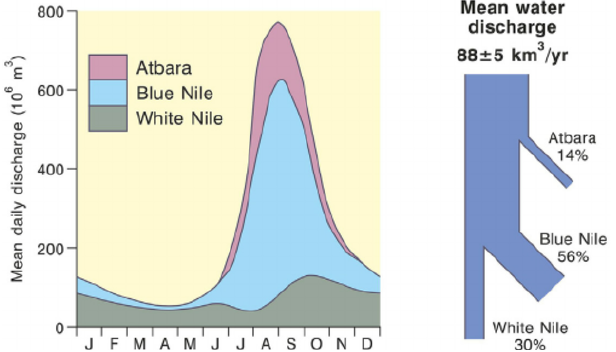
Figure 4. The flow regime of the Nile showing the typical contribution of the three main tributary basins. White Nile is almost constant throughout the year. Figure from [60] based on data from